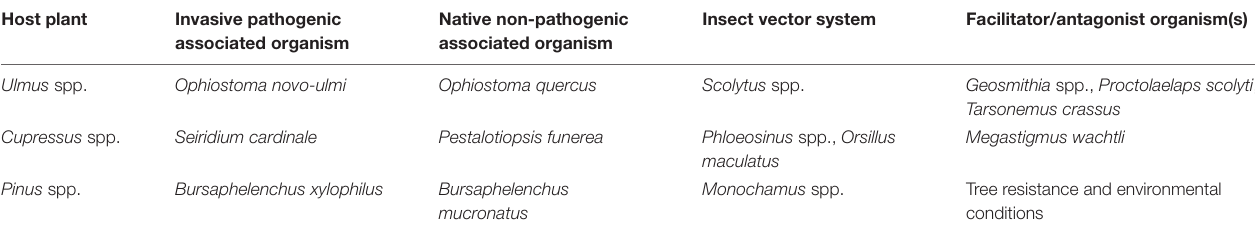
TABLE 1 | Organisms involved in three tree pandemics, i.e., Dutch elm disease, cypress canker, and pine wilt disease. Host plant